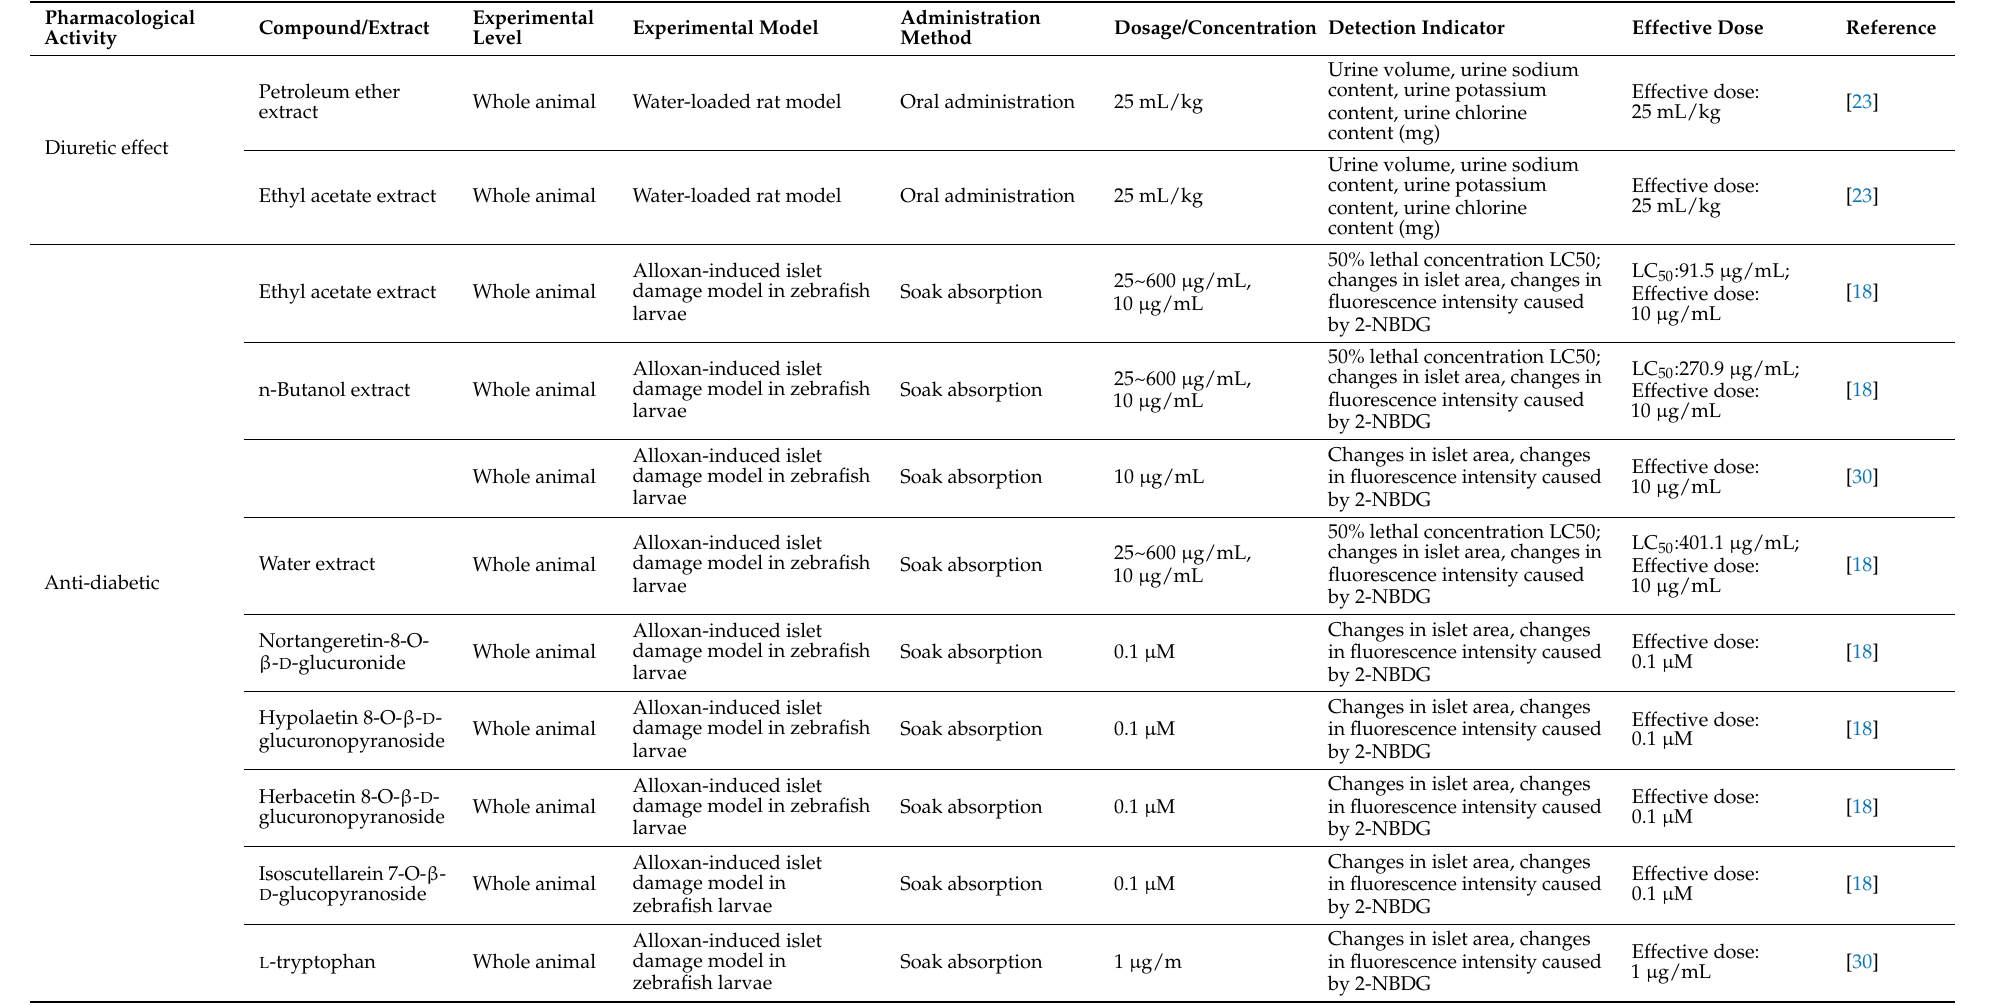
Table 9. The research progress on the pharmacological activity of Fructus Malvae